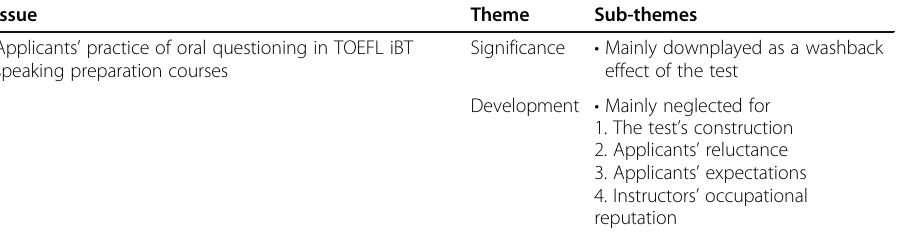
Table 5 Major themes and sub-themes about the TOEFL iBT instructors ’ perceptions of learners ’ questions TOEFL iBT speaking preparation courses